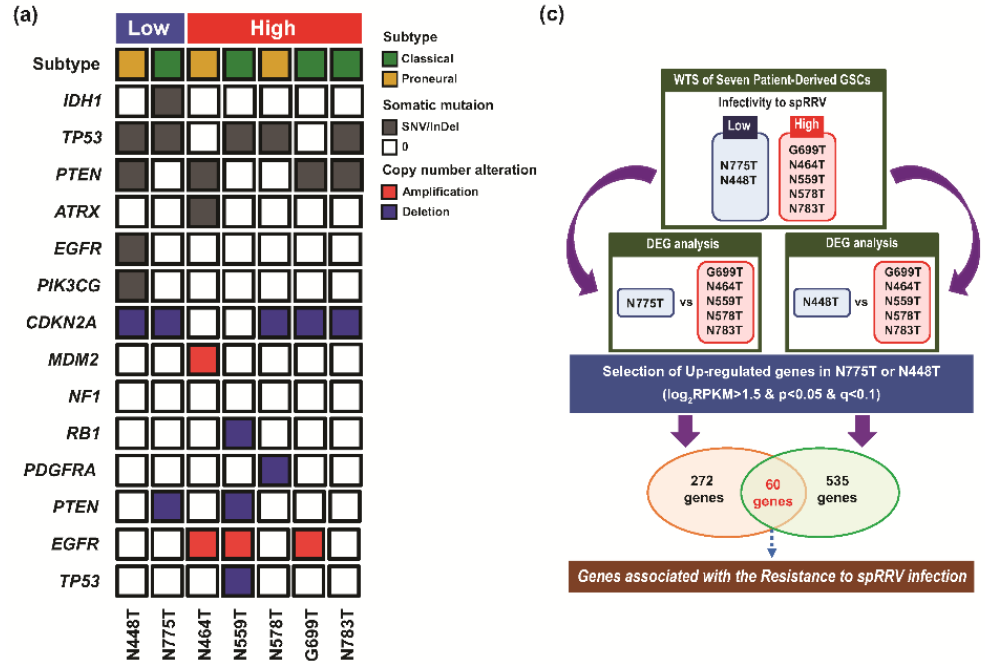
Figure 5 . Cont. Figure 5.